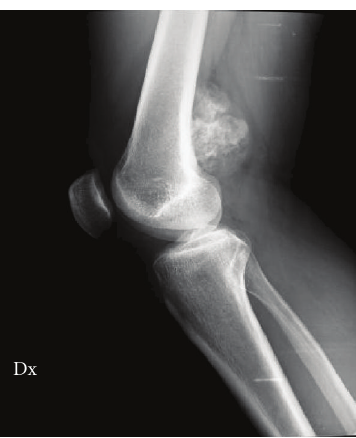
Figure 1: Preoperative radiography showed a relatively dense and well-demarcated ossified mass at a juxtacortical lesion of the distal femur.